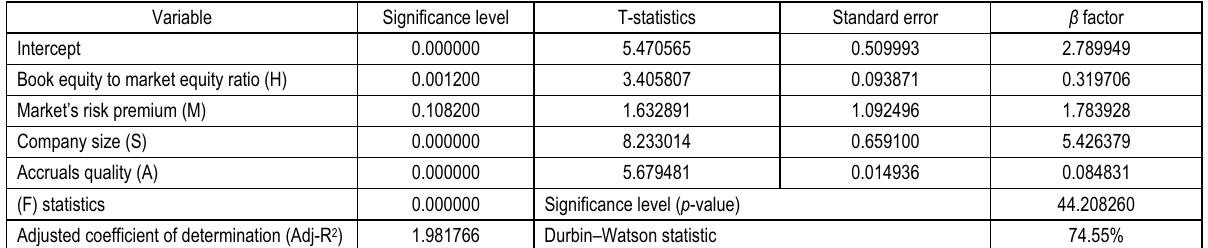
Table 8. Relation between investment anomaly and Stock’s risk